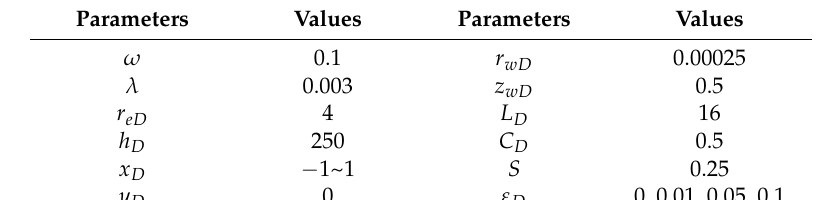
Table 3. Basic data used in Figure 4.